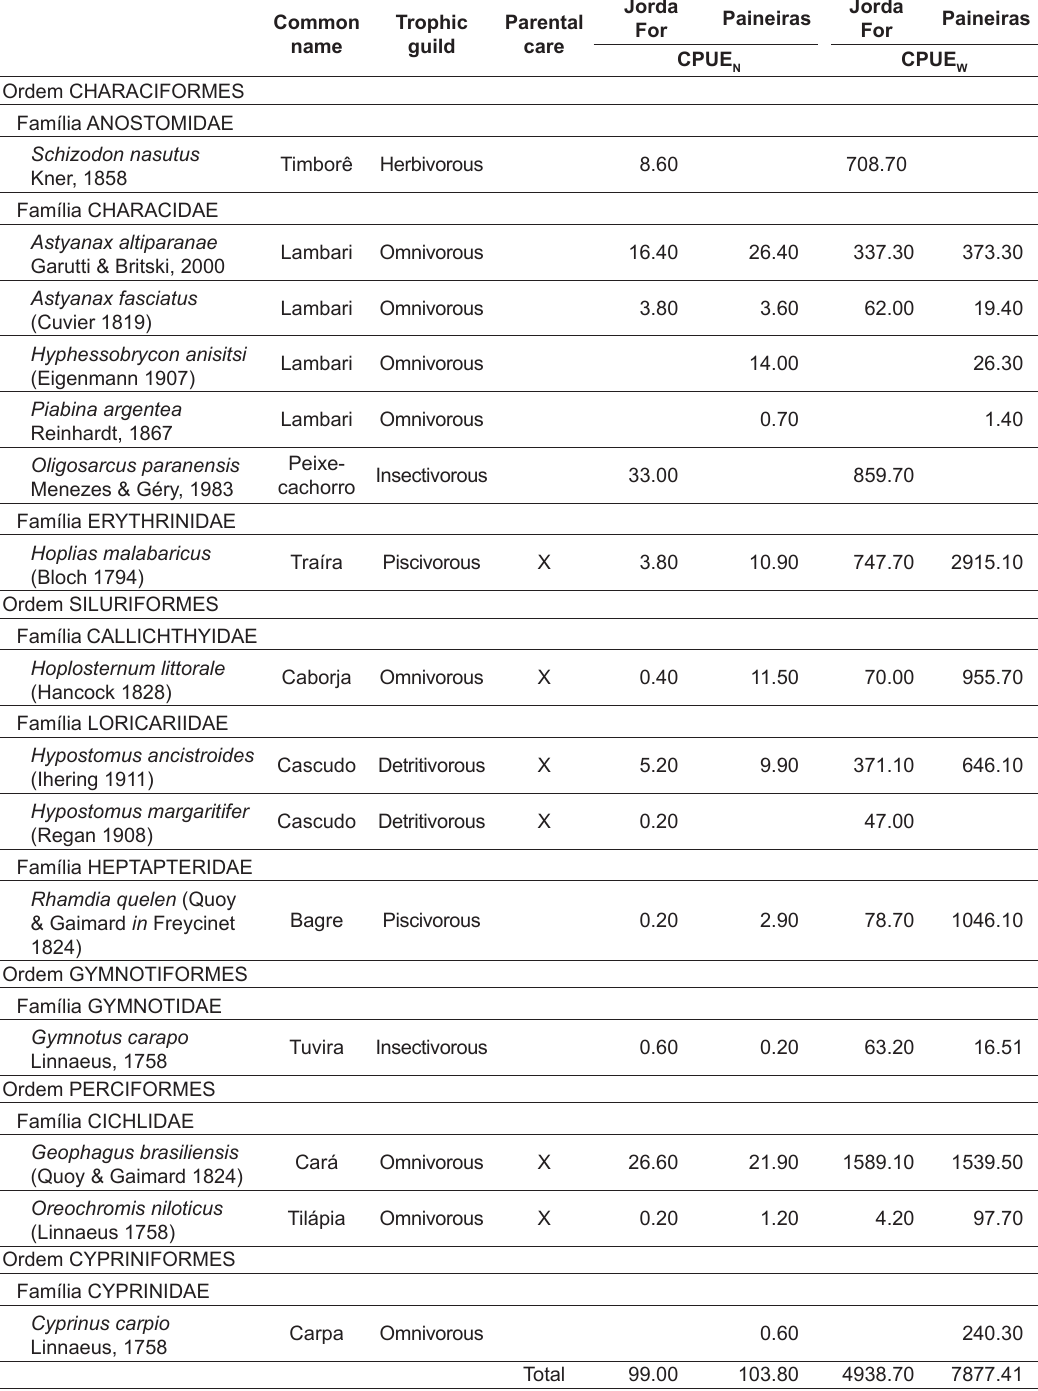
Table 2. Species captured in the Paineiras and Jorda Flor reservoirs. CPUE of individuals; CPUE